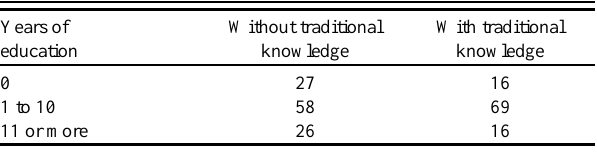
Table 5 . Cross-tabulation of respondents by level of education and possession of traditional knowledge for predicting